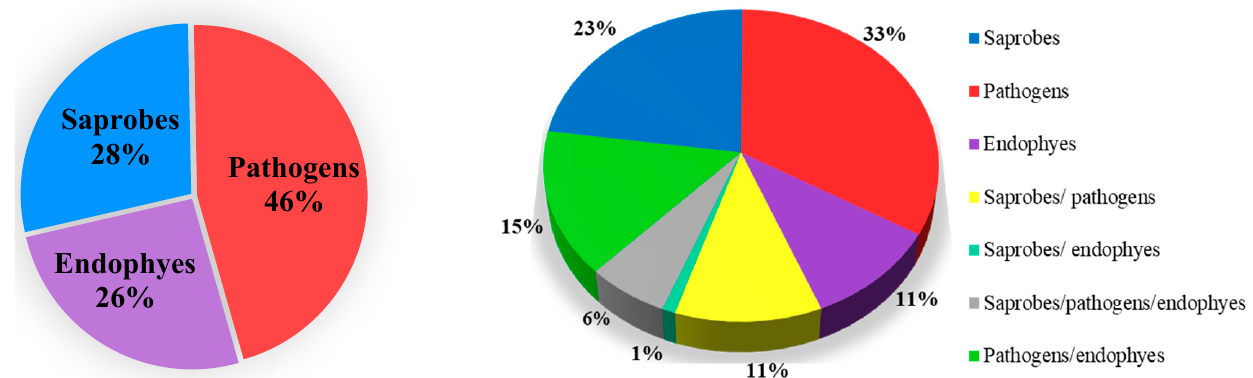
Figure 6. Nutritional modes recorded in Botryosphaeriales Figure 6 . Nutritional modes recorded in Botryosphaeriales taxa .